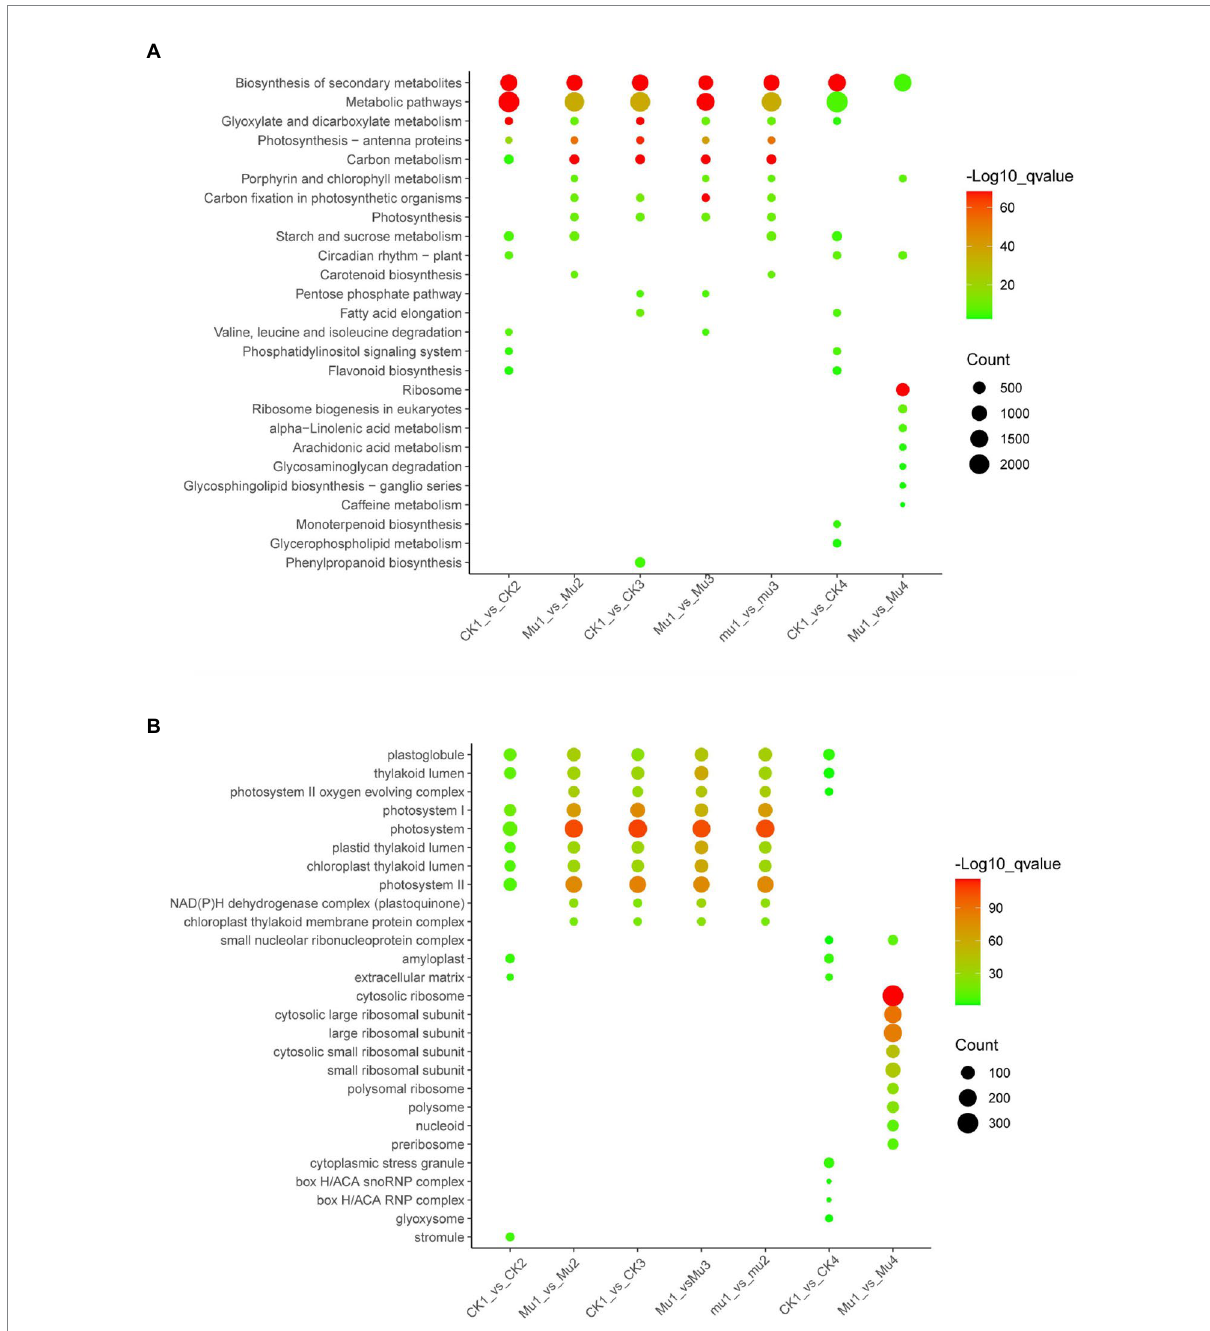
FIGURE 9 KEGG and GO enrichment of DEGs during drought stresses and rehydration. The most enriched top10 pathways and GO terms are displayed. (A) KEGG enrichment of DEGs during drought stresses and rehydration. (B) GO enrichment of DEGs during drought stresses and